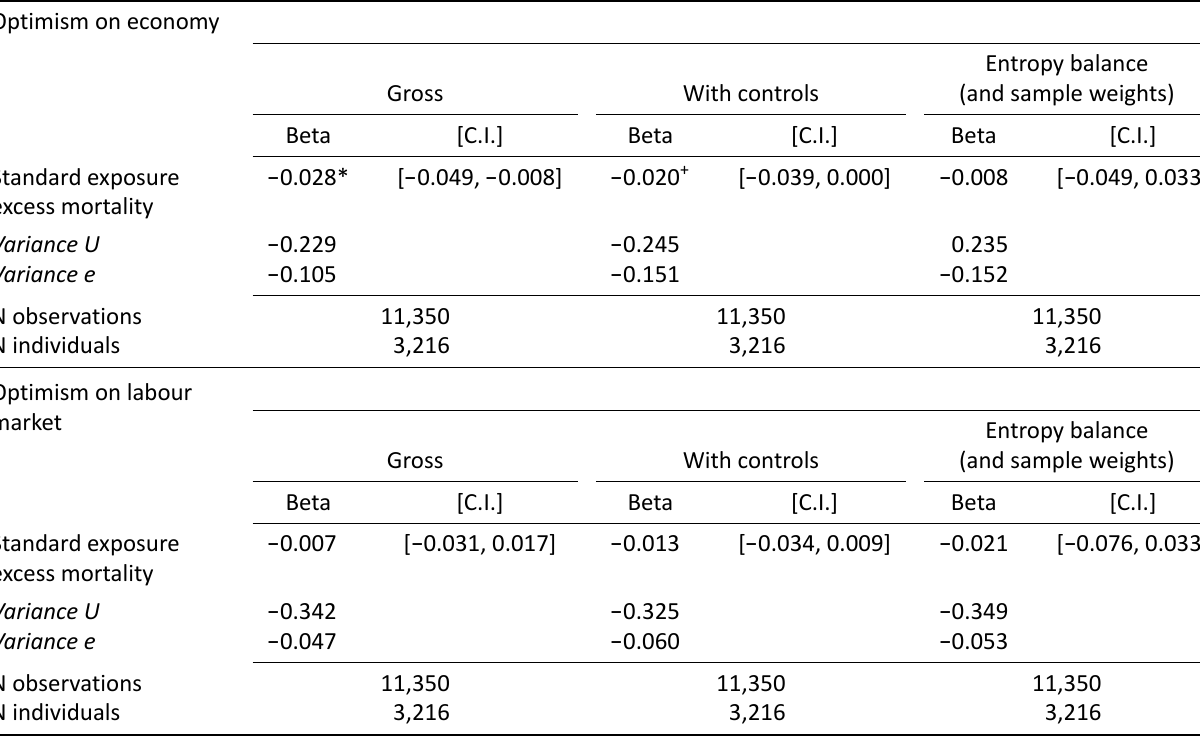
Table 1. Linear mixed models predicting dispositional optimism towards the economy and the labour market. Optimism on